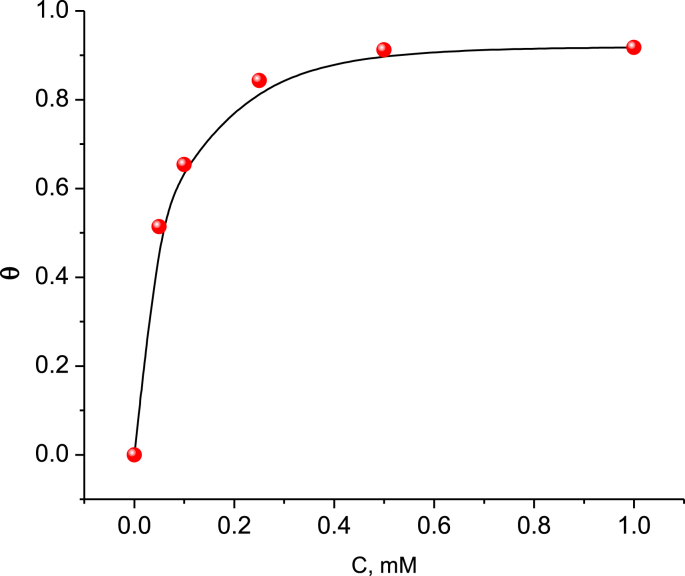
The simple relationship between θ and BQYP concentration at 298 °K.